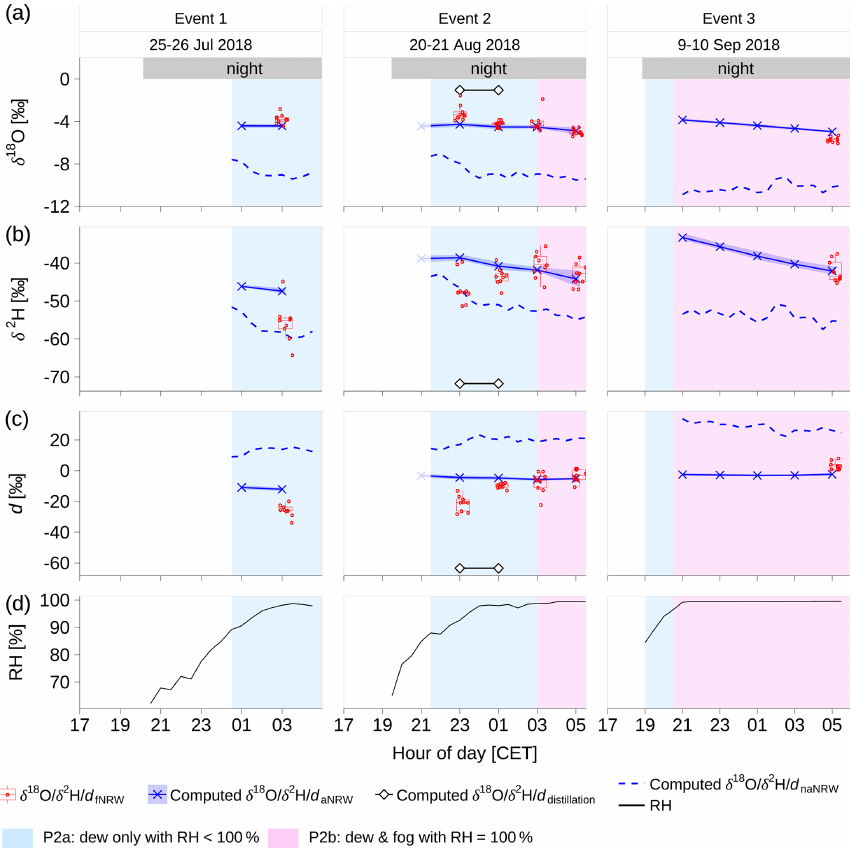
Figure 7. The isotopic composition of different non-rainfall water (NRW) components: δ 18 O fNRW , δ 2 H fNRW , and d fNRW for NRW on foliage; δ 18 O aNRW , δ 2 H aNRW , and d aNRW for computed NRW equilibrium liquid from ambient water vapor; δ 18 O distillation , δ 2 H distillation , and d distillation for distillation computed from two-end-member mixing model; δ 18 O naNRW , δ 2 H naNRW , and d naNRW for NRW computed from ambient water vapor considering both equilibrium and non-equilibrium factors. The corresponding relative humidity (RH) at 2ma.g.l. was also shown synchronously. The shaded areas indicated different periods of environmental conditions as described in Sect. 4.1. The P2a period was the dew formation period in the conditions of relative humidity < 100%; the P2b period was the combined dew and radiation fog period in the conditions of relative humidity =